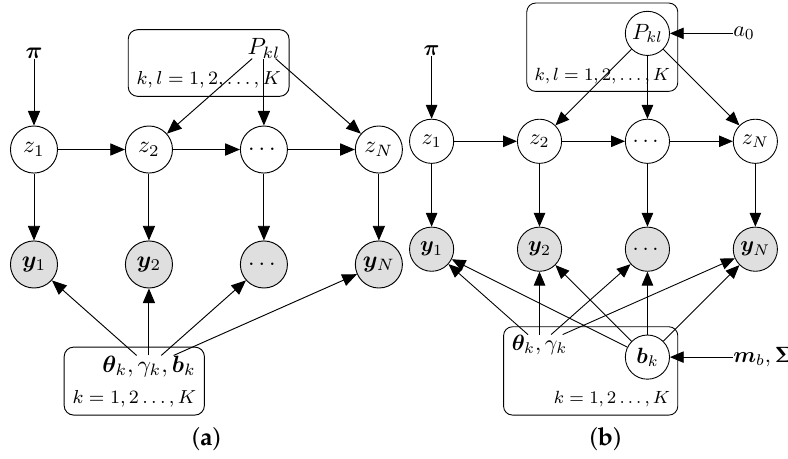
Figure 2. Probabilistic graphical models of HM-GPFR ( a ) and BHM-GPFR ( b